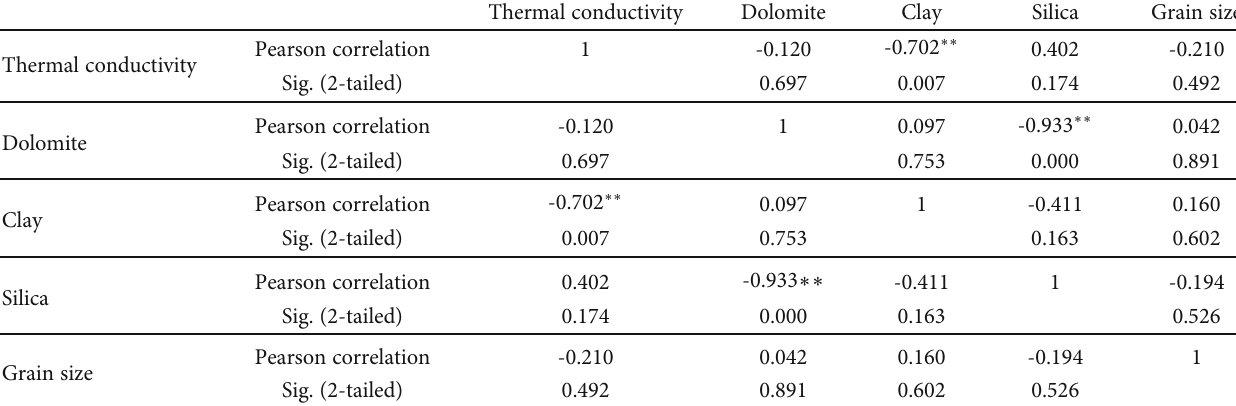
Table 9: Correlations between thermal conductivity and composition of dolomite.